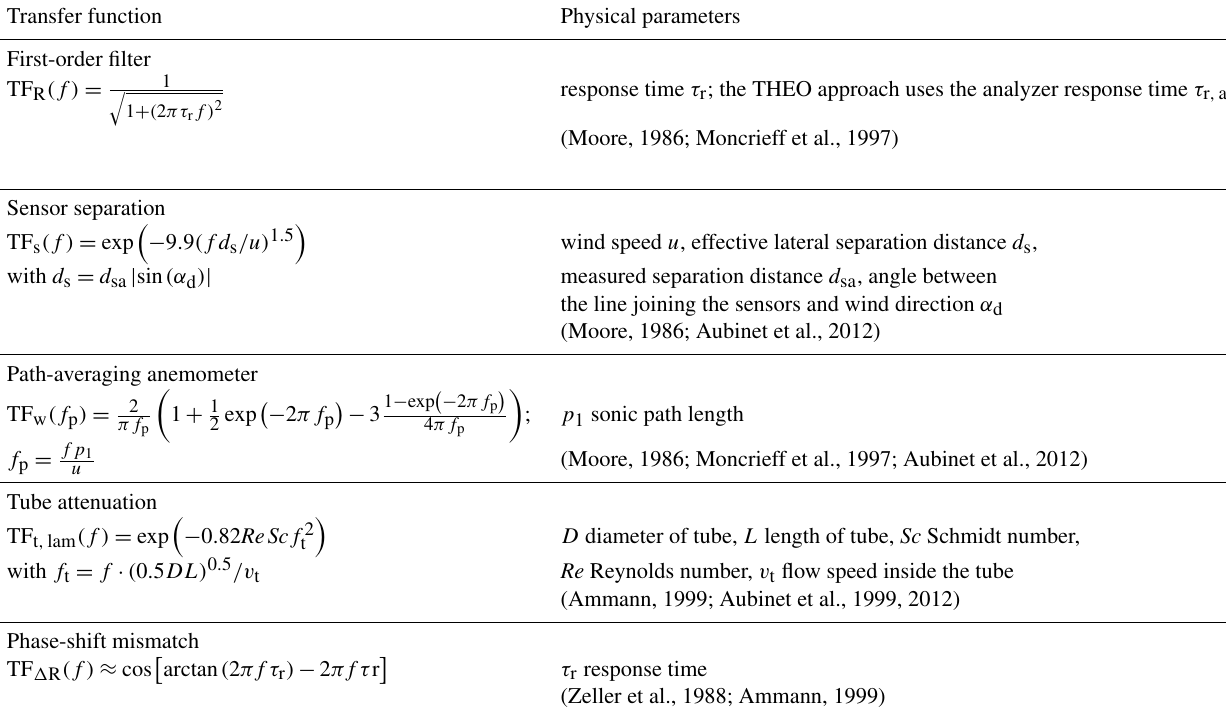
Table A1. Transfer functions used for evaluation of the (cid:54) N r damping